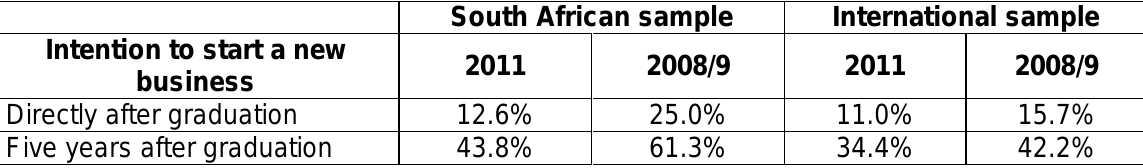
Table 6 Changes in career intentions over time South African sample International